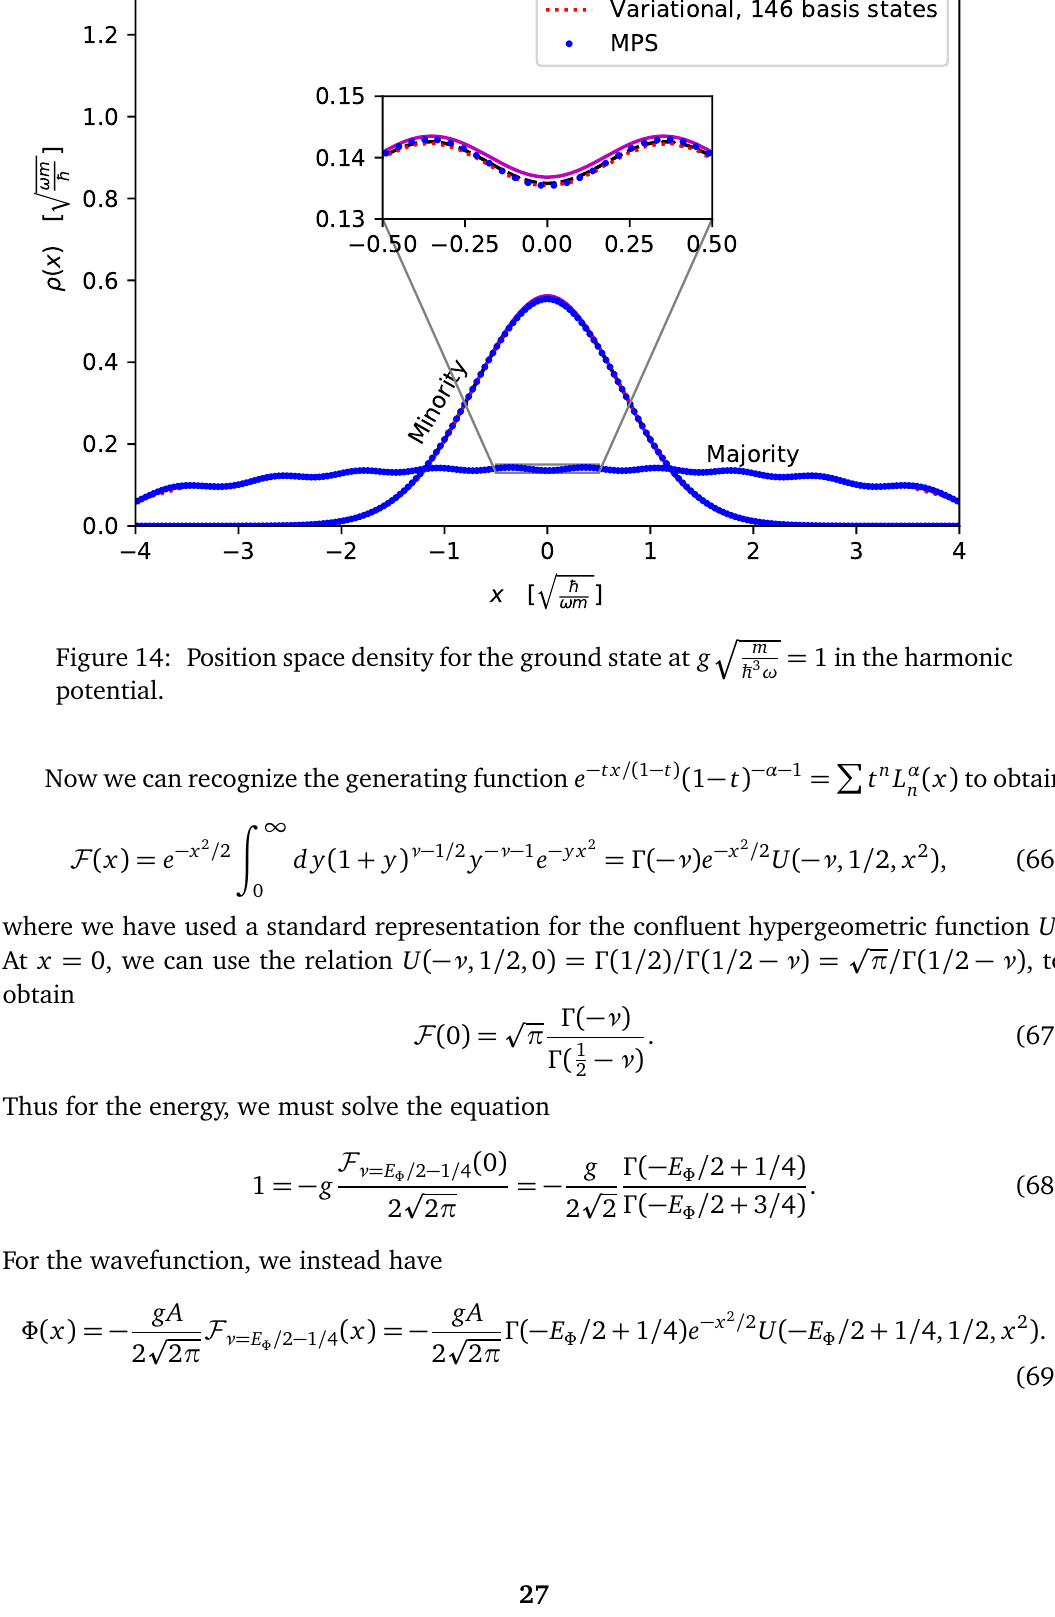
Figure 14: Position space density for the ground state at g